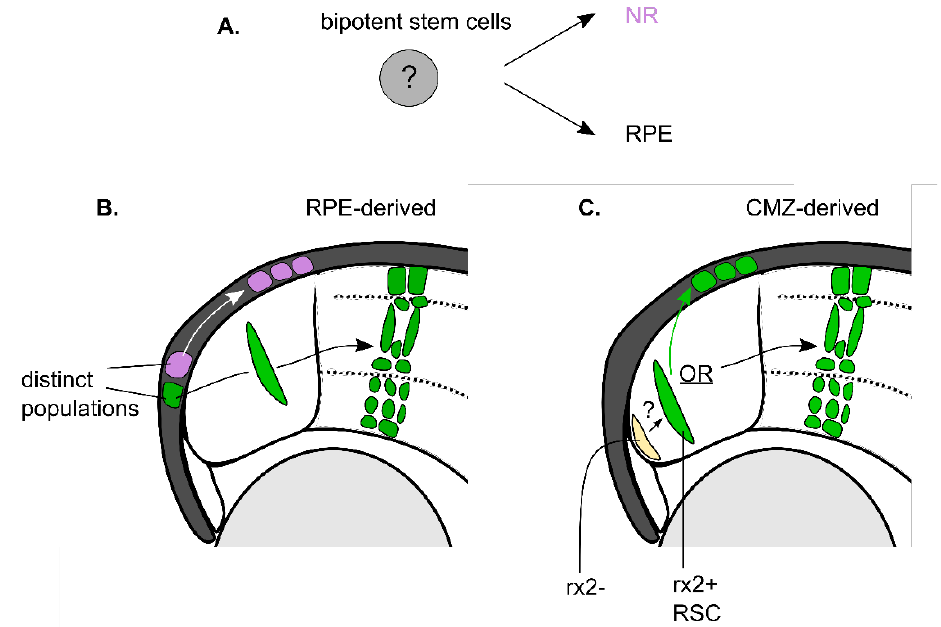
Figure 3. RPE and NR cells are generated from distinct stem cell populations at the margin. ( A ) Schematic of what a ‘bipotent’ stem cell represents—a cell capable of producing both neural retinal cells (NR) and retinal pigmented cell (RPE) lineages. ( B ) Cells in the RPE of the teleost show are shown to contain cell populations that give rise to the RPE or the NR [46]. However, the RPE and NR cells have distinct cell origins, suggesting a bipotent stem cell does not exist in the RPE. Pink cells (that produce RPE) and g reen cells (that produce NR) represent distinct stem cell populations. ( C ) CMZ rx2+ cells ( green cell in the CMZ) can give rise to RPE or NR but not to both simultaneously, suggesting these cells are also not bipotent but become committed to one of the lineages [44]. The rx2+ cells appear to choose between the two fates. Therefore, all cells are represented as green to display the different paths an rx2+ cell can choose. At the far periphery of the CMZ are rx2- cells ( light yellow ), and it currently remains unknown whether they can contribute to the production of the rx2+ RSC population (this uncertainty in represented by a ‘?’).